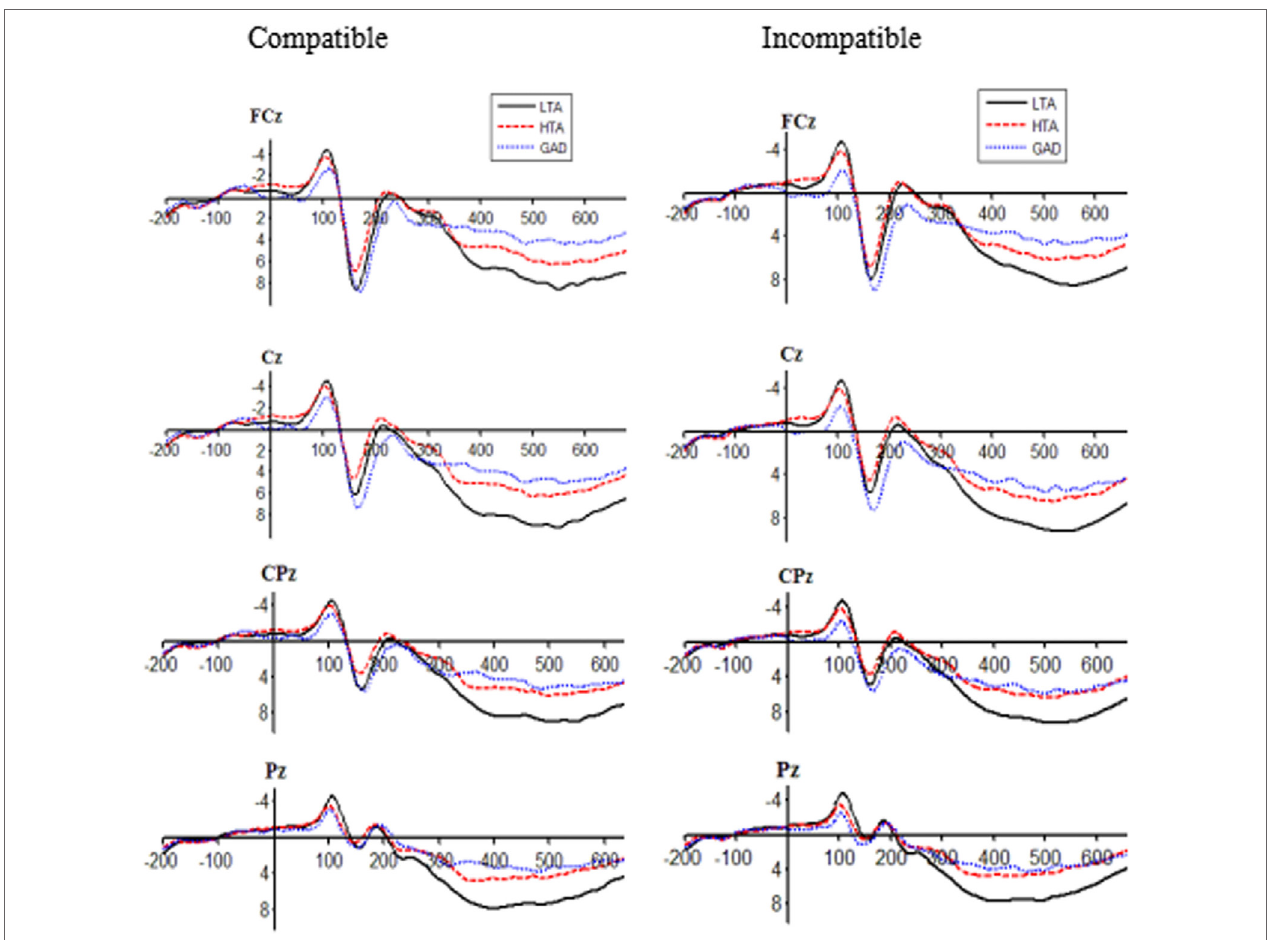
FigUre 2 | Stimulus-locked event-related potentials for the low trait anxiety (LTA), high trait anxiety (HTA), and generalized anxiety disorder (GAD) groups in compatible and incompatible conditions at FCz, Cz, CPz, and Pz